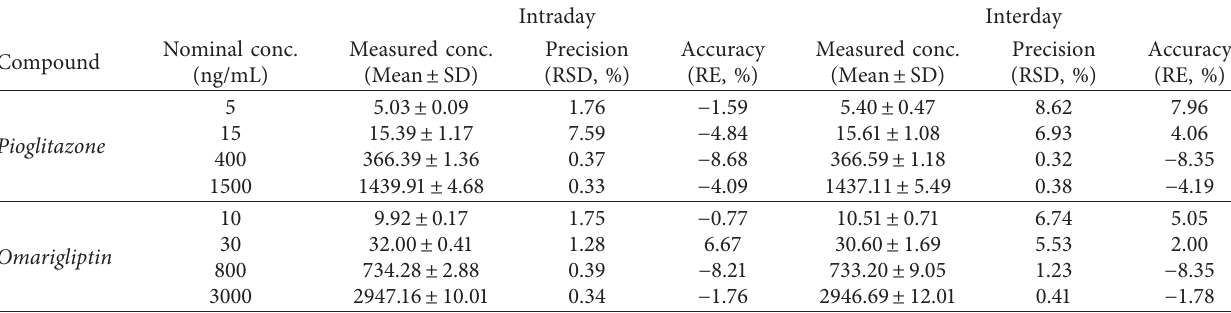
Table 3: Precision and accuracy for the analysis of pioglitazone and omarigliptin in rat plasma ( n � 6). Intraday Interday Nominal conc. Measured conc. Precision Accuracy Measured conc. Compound